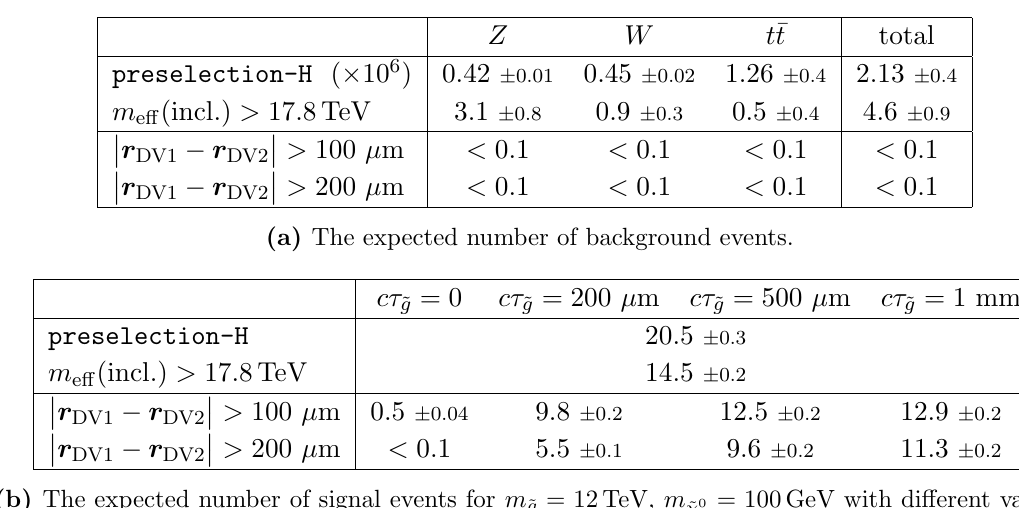
Table 13. The expected number of background (a) and signal (b) events for an integrated lumi- nosity of L = 3000 fb (cid:0) 1 . We set the masses of gluino and the LSP to be 12 TeV and 100 GeV,